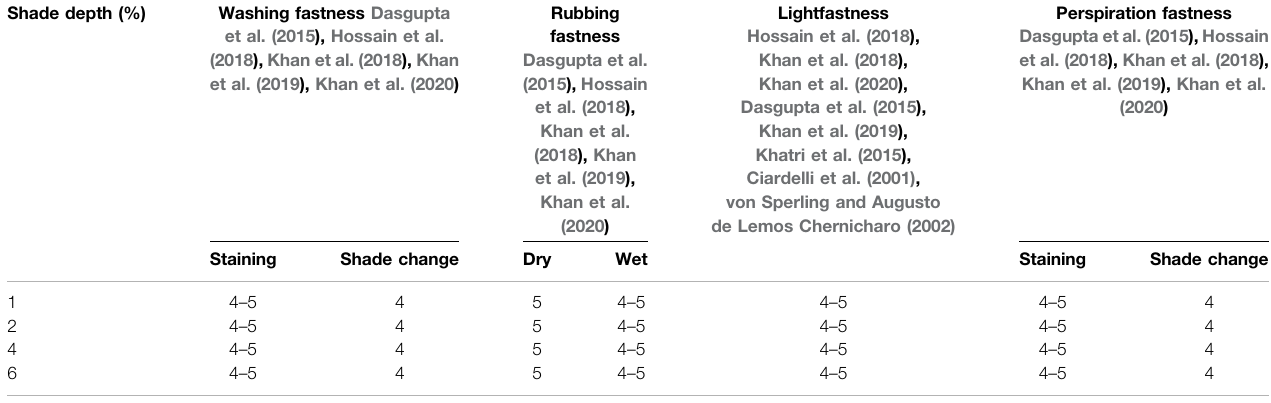
TABLE 1 | Colorfastness results of un-cationized cotton dyed samples recorded according to standard test protocols. Shade depth (%)